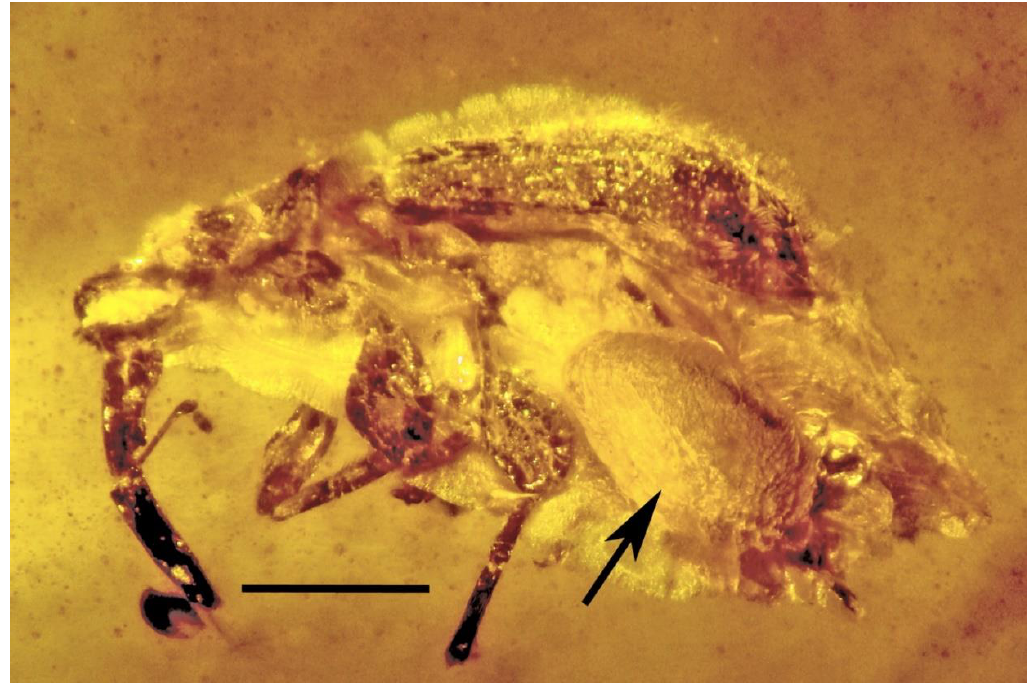
Figure 15. A parasitized weevil, Habropezus plaisiommus (Coleoptera: Ithyceridae: Carinae), with a euphorine braconid cocoon (arrow) (Hymenoptera: Braconidae) in Burmese amber. Scale bar = 800 µm.